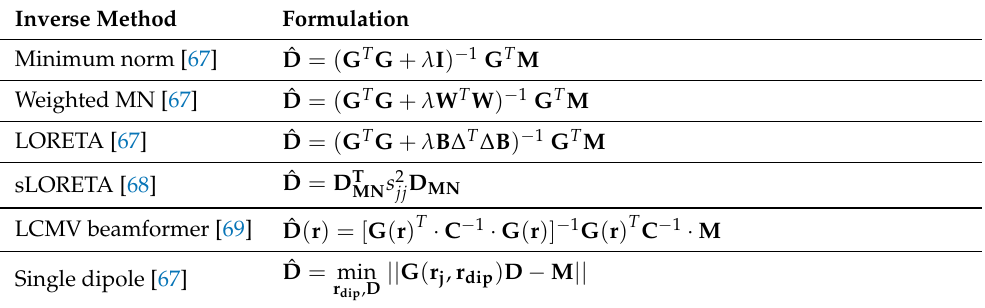
Table 4. Inverse method specific